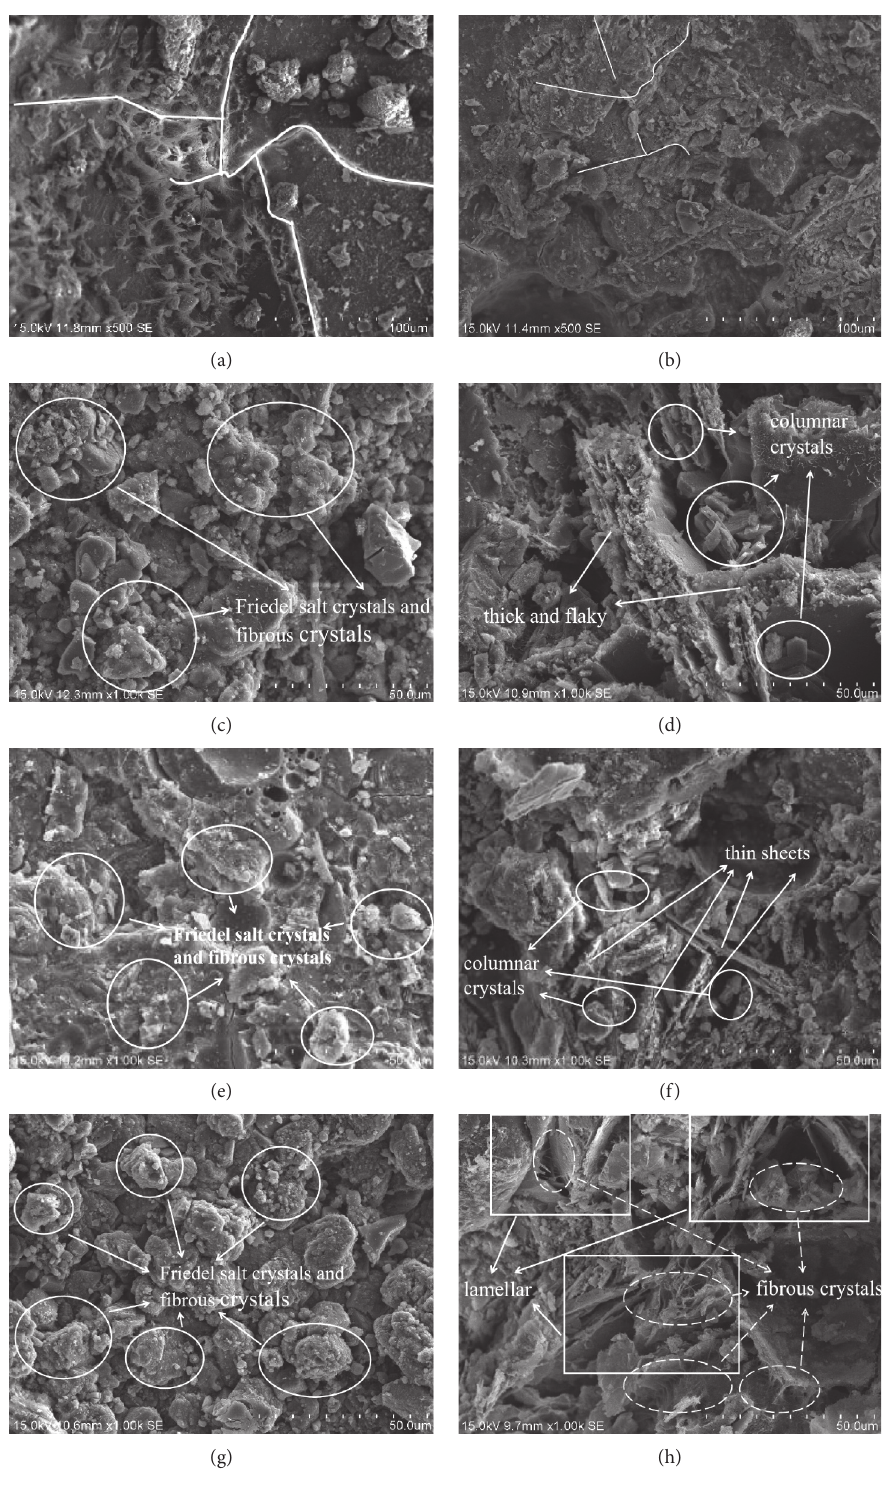
Figure 4: SEM image of concrete under different soaking